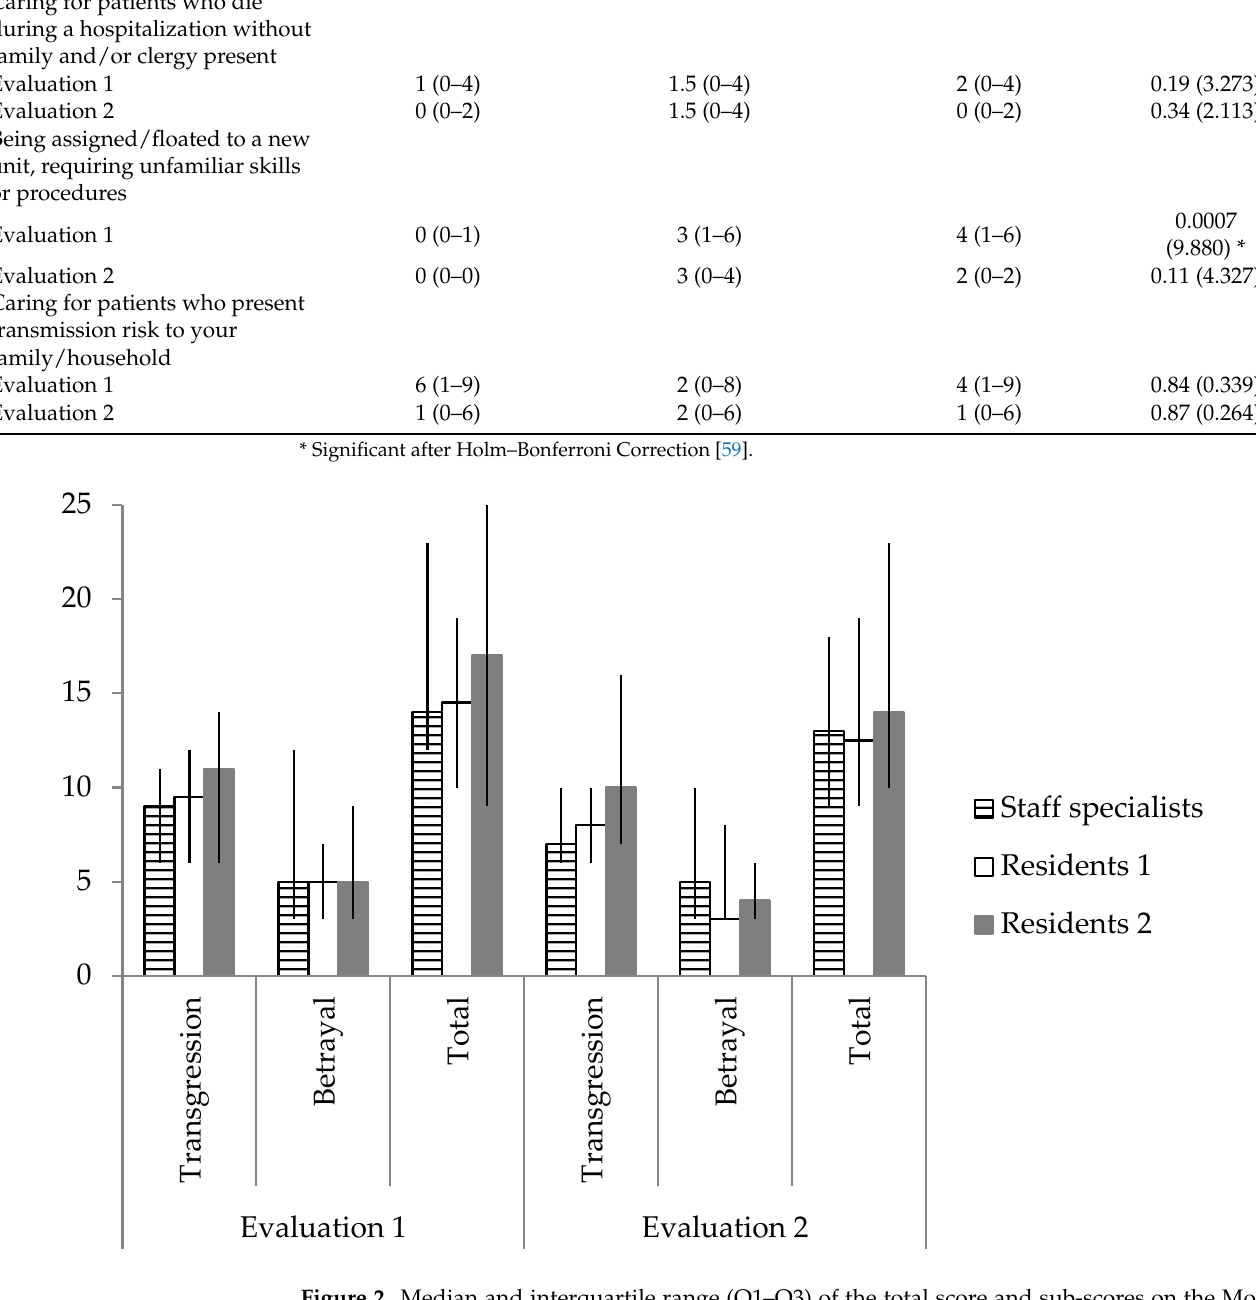
Figure 2. Median and interquartile range (Q1–Q3) of the total score and sub-scores on the Moral Injury Event Scale of 108 physicians in the two evaluations of the study, with three months in between. Residents 1 = residents since wave 1 = Residents 2 = residents since wave 3.